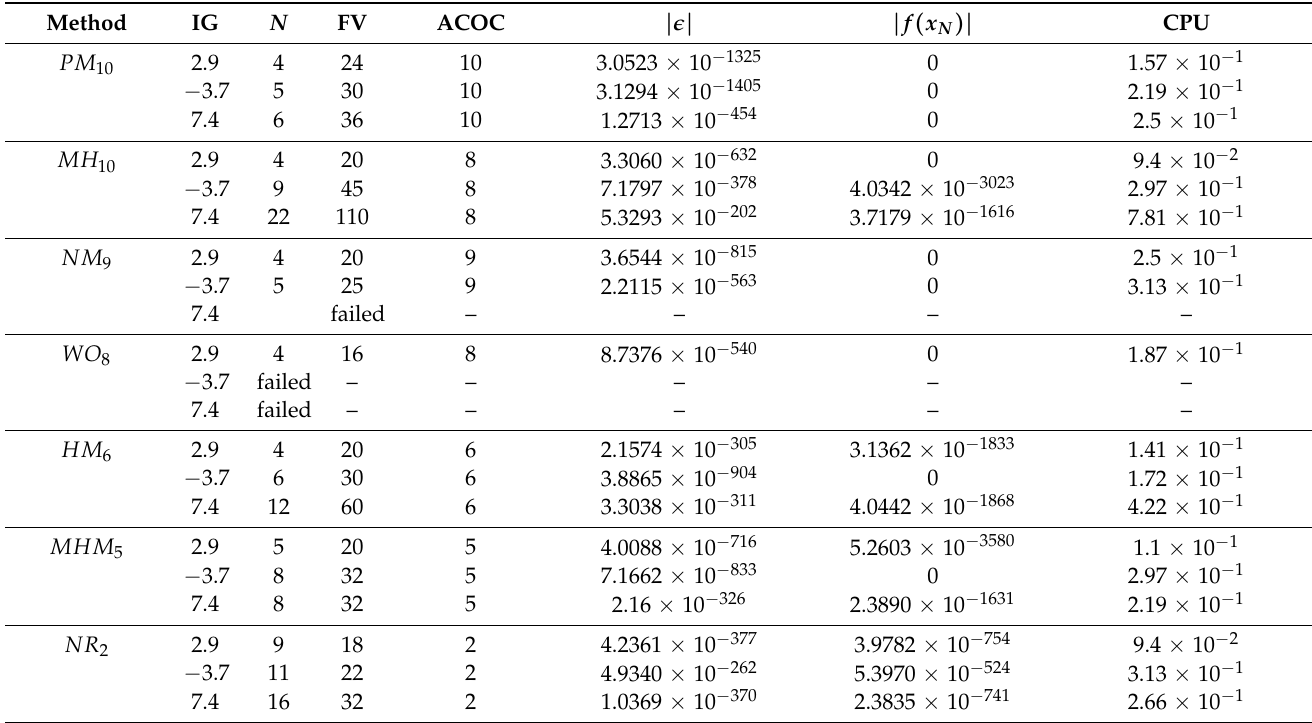
Table 7. Numerical results for problem 2: g 5 ( x )